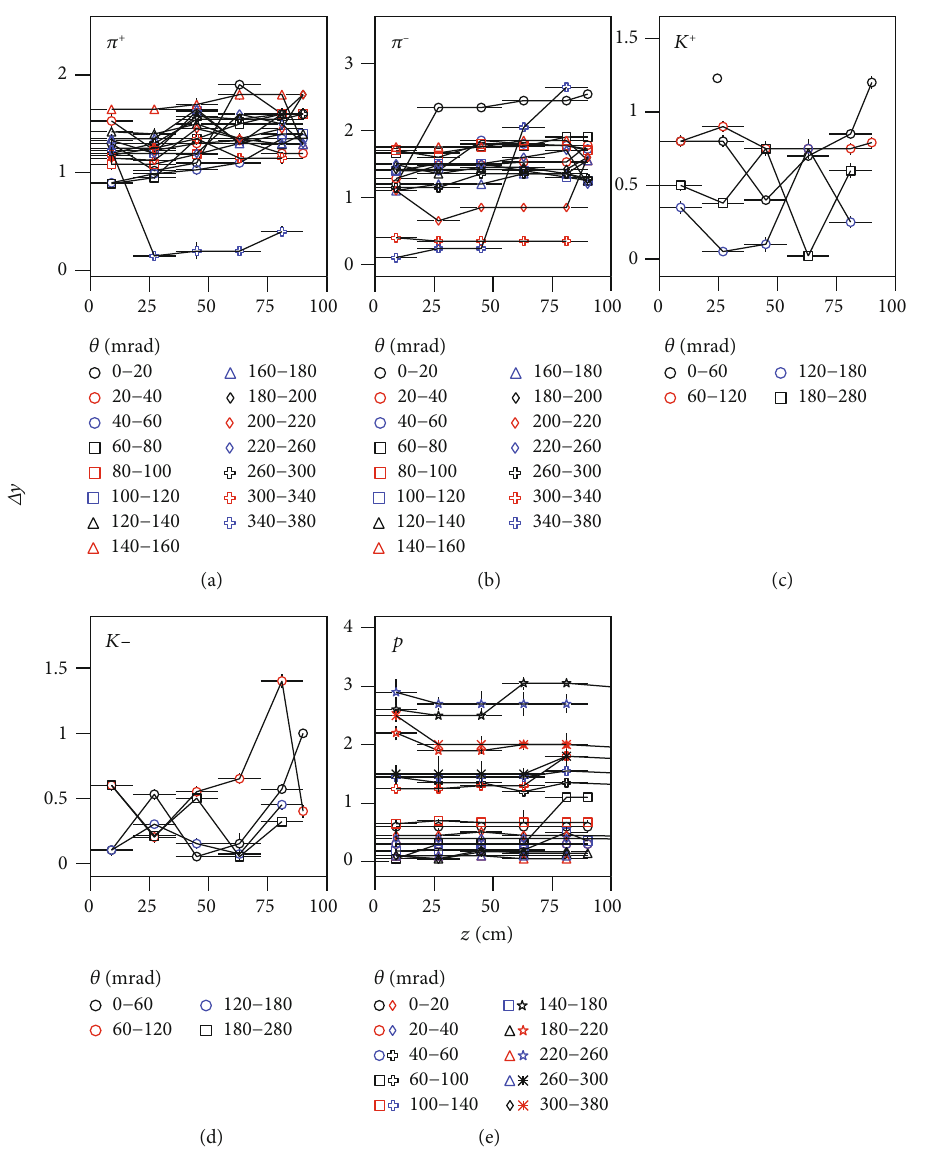
Figure 10: Same as Figure 9 but showing the dependence of Δ y . Large Δ y ð = y shifts for leading